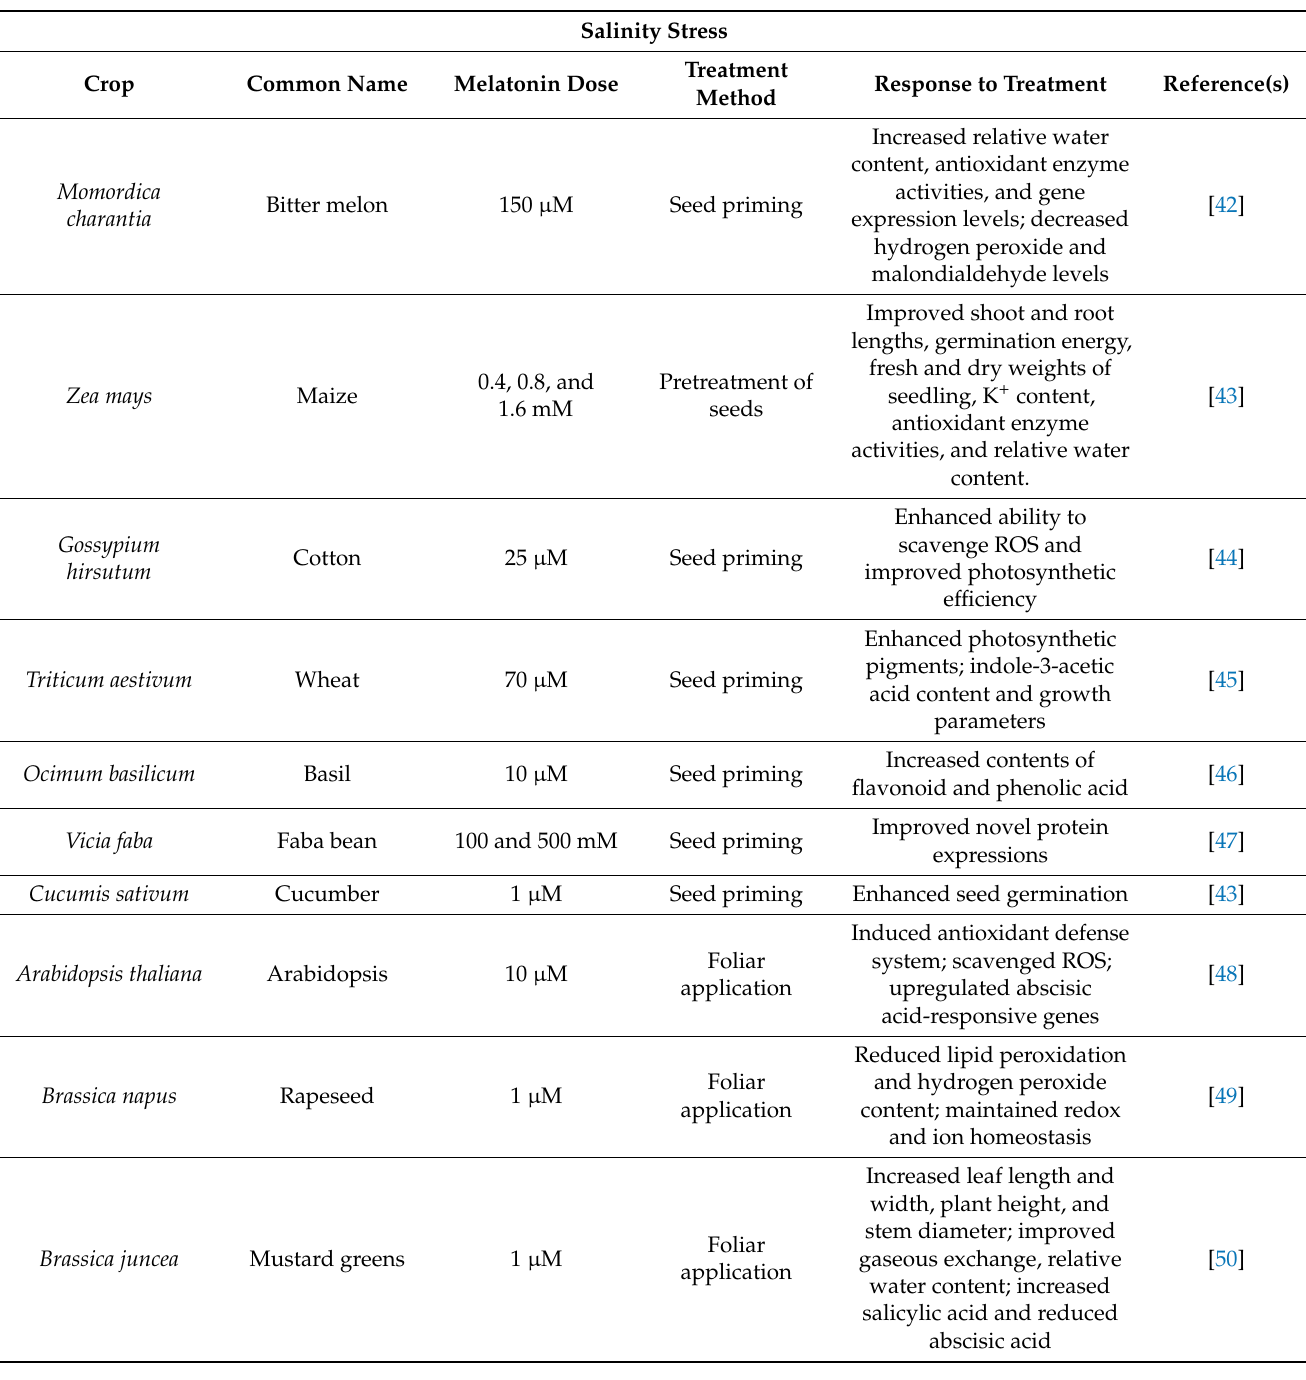
Table 2. Physiological responses of various crops to melatonin treatment against salinity